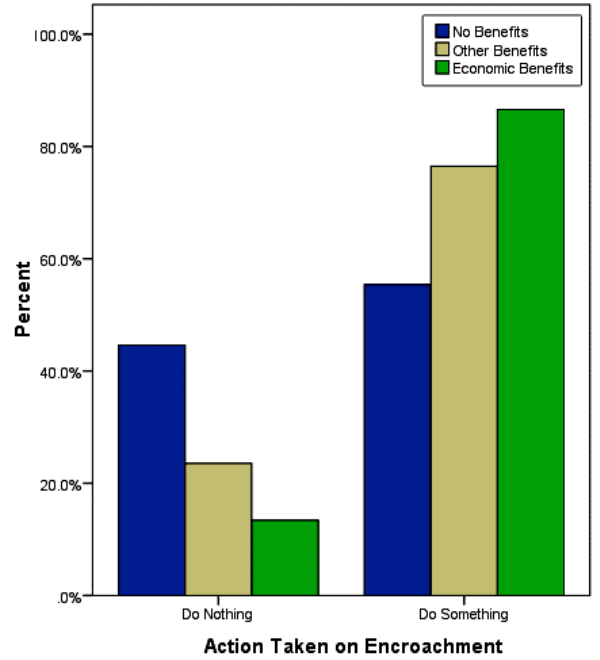
Fig. 4 . Differences in whether action was undertaken upon spotting a poacher among individuals who perceived various marine protected area benefits.